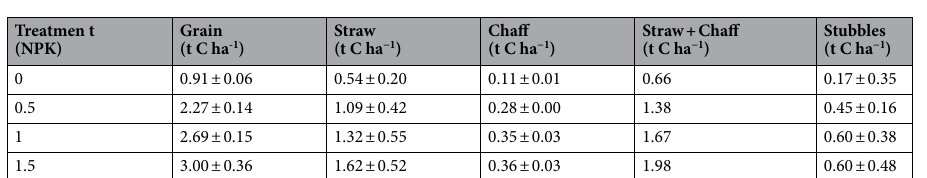
Table 2. The amounts of C in mature winter wheat grain, straw (without stubbles), chaff, and stubbles fractions measured in the B2e-field in 2020. Average ± standard error of the mean (SE, n = 4).